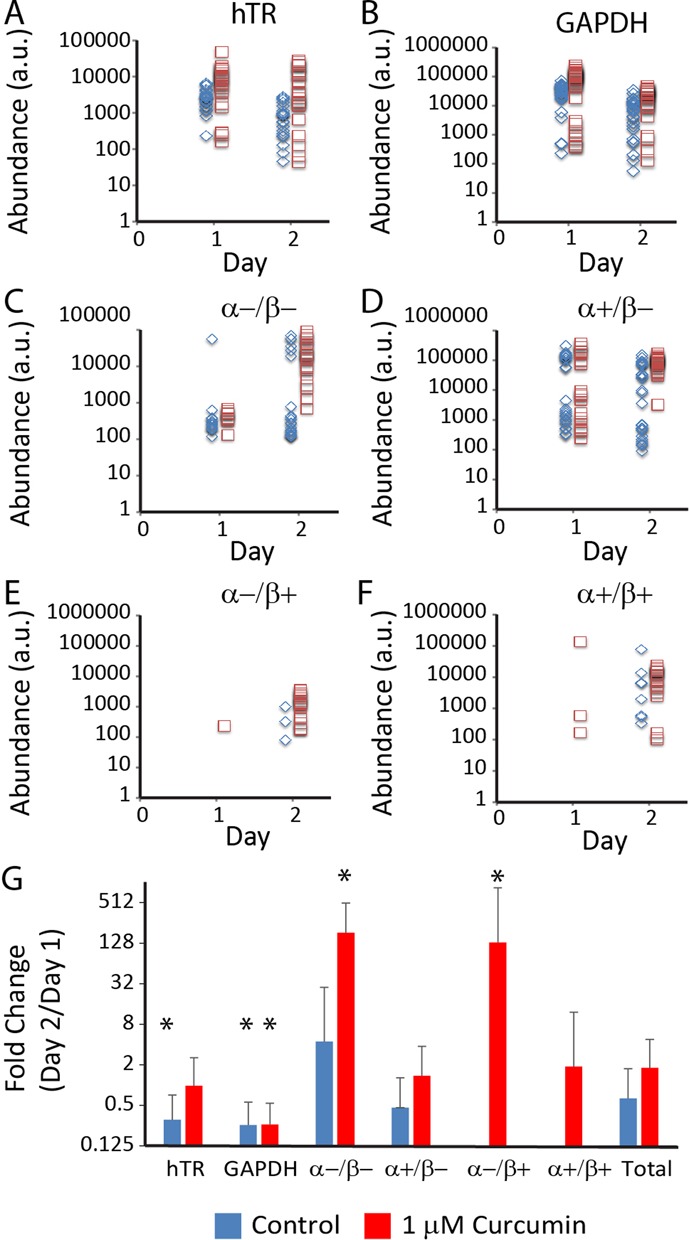
(A–F) Scatter plots of transcript abundance for all gene targets on days 1 and 2 for K562 cell cultures treated with DMSO (blue diamonds) and 1 μM curcumin (red squares). Curcumin treatment results in overall higher transcript abundance for all targets, but primarily increases abundance of both enzymatically-inhibitory α− splice variants, thereby reducing bimodality of total hTERT transcript abundance. (G) Graph showing change in mean transcript abundance from day 1 to day 2 for each target. Stars indicate statistically significant (P < 0.01) and biologically relevant (fold change > 2 or < 0.5) modulation of RNA levels between day 1 and day 2. Fold change values could not be calculated for α−/β+ and α+/β+ splice variants for control colonies and were omitted from the plot. The >100 fold increase in abundance of α− variants on day 2 suggests a strong impact of curcumin on α− splicing at sub-lethal concentrations.